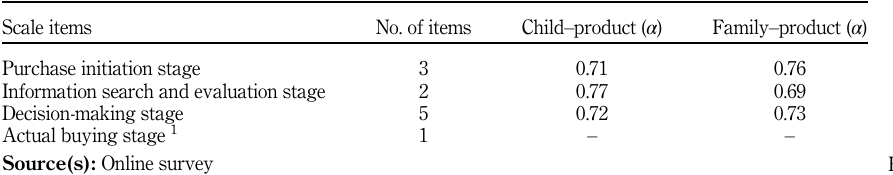
Table 2. Reliability analyses of